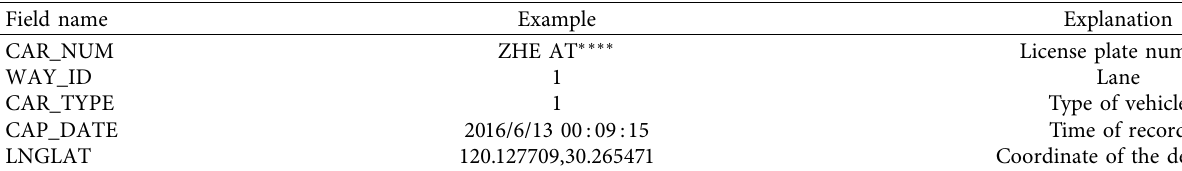
Table 1: The details and examples about the